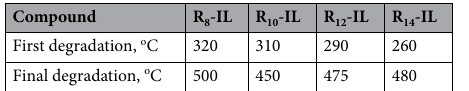
Table 5. Characteristic TGA results of the synthesized ionic liquids.